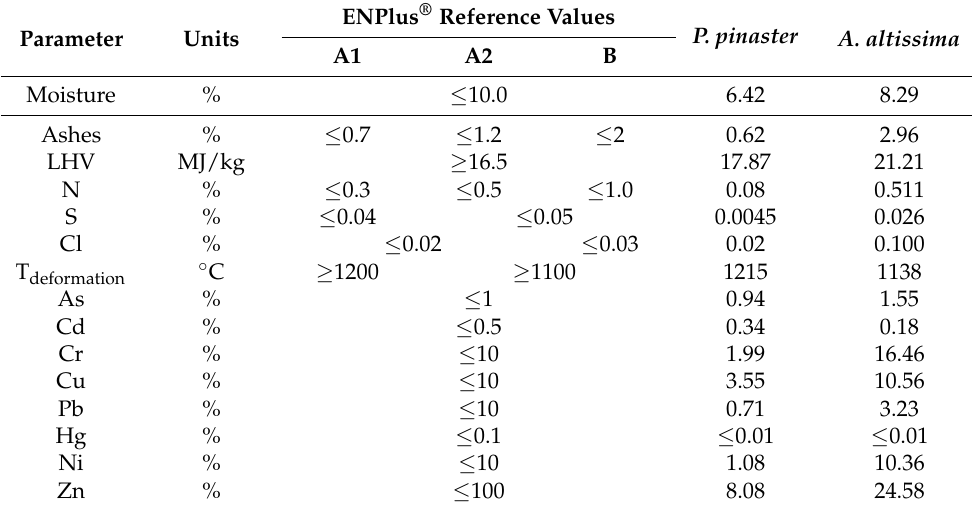
Table 6. Comparison of values for the reference parameters of the standard ENPlus ® for P. pinaster and A. altissima (adapted from